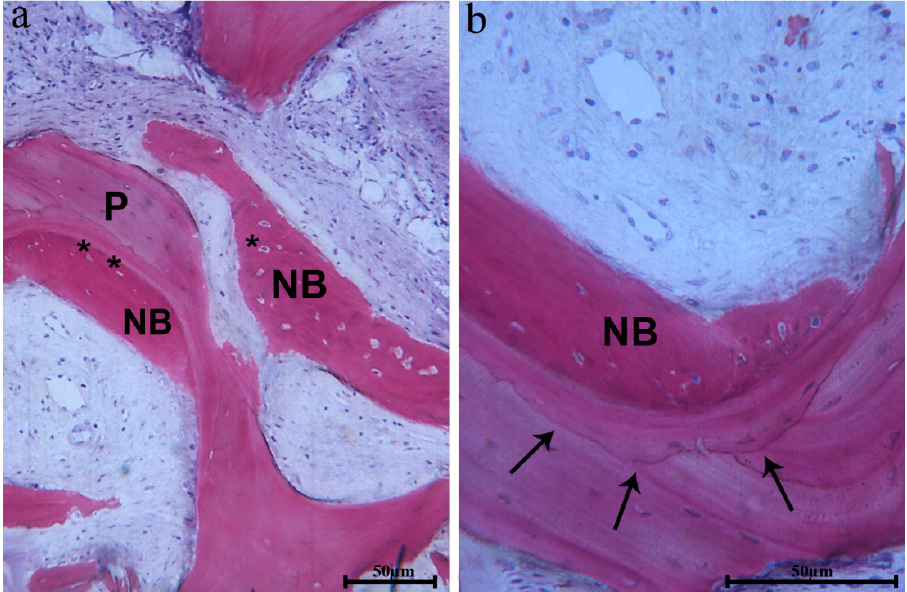
Figure 7. Histologic views: ( a ) newly formed bone (NB), with the presence of large osteocytes lacunae (*) close to the biomaterial particles (P) is observed; ( b ) newly formed bone (NB) and biomaterial interface (black arrows) show a similar affinity for dyes. (Acid fuchsin-Toluidine blue 100 and 200X).